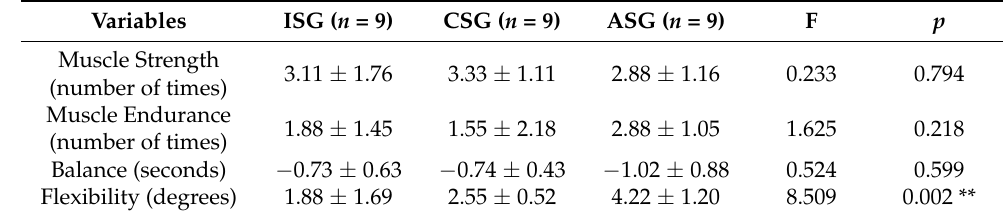
Table 4. Differences in physical ability between the